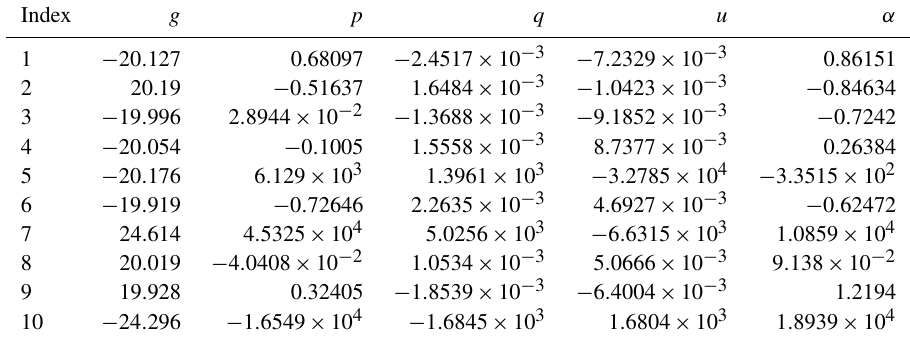
Table A4. Coefficients for D 250 in Eq. (A6).